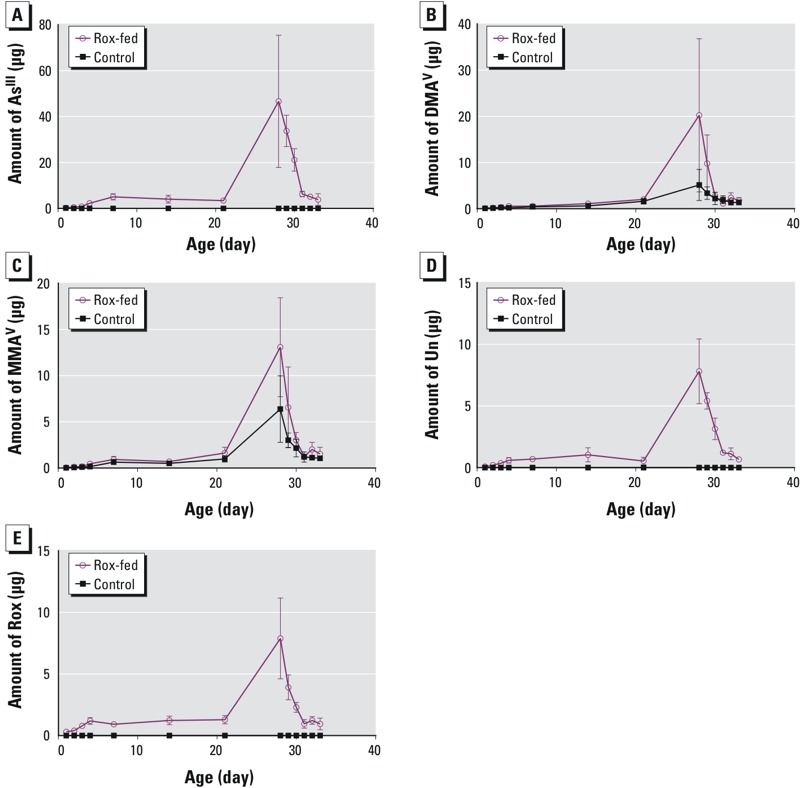
Content of (A) AsIII, (B) DMAV, (C) MMAV, (D) Unknown arsenic species (Un), and (E) Rox in the breast samples of control and Rox-fed chickens. The amount of arsenic species (μg) was obtained by multiplying the concentrations of arsenic species in each sample by its sample-specific body weight. Data represent mean values and error bars represent one standard deviation from duplicate analyses of 5–8 chicken samples.